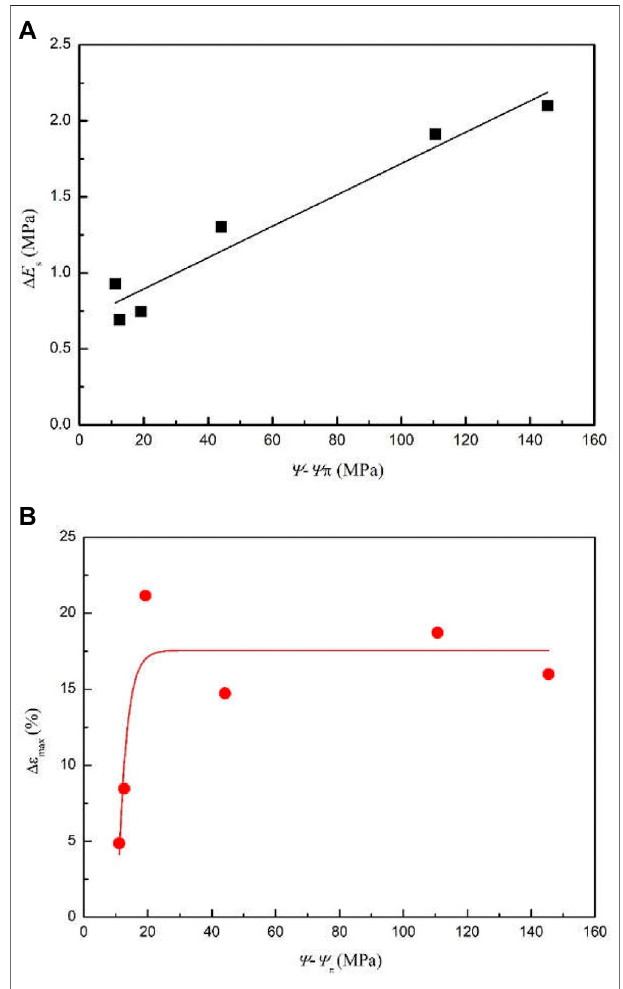
FIGURE 11 | The differences of compression parameters changed with Ψ - Ψ π : (A) Δ E Ψ - Ψ π ; (B) Δ ε Ψ - Ψ π s versus max versus